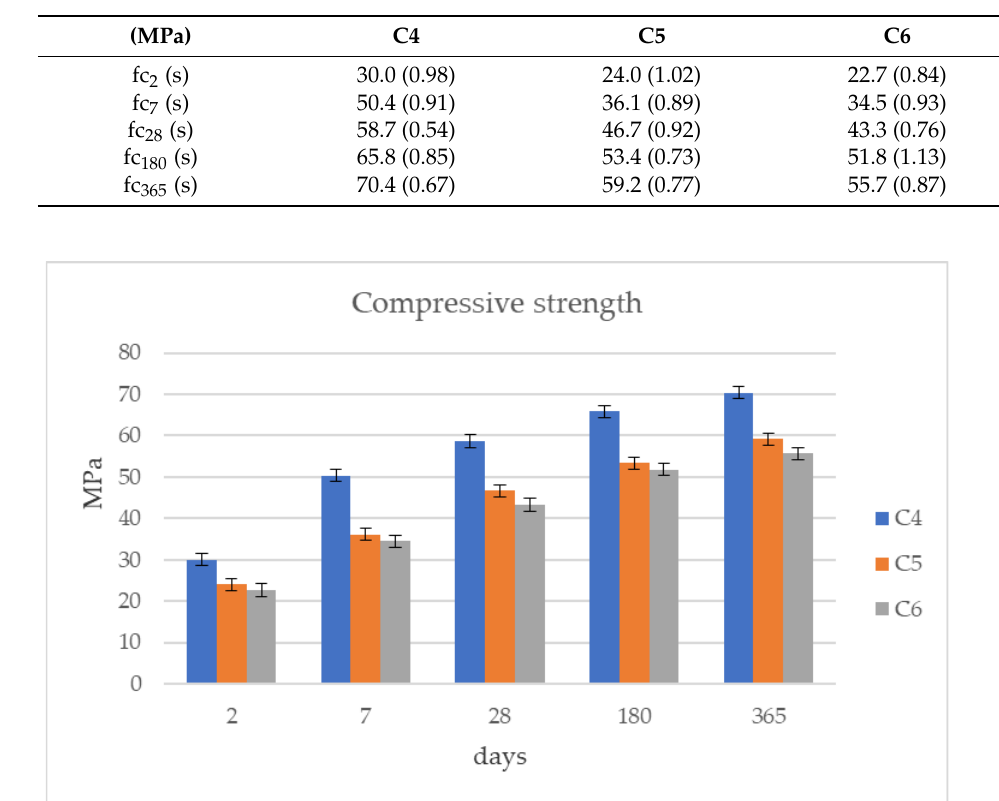
Table 7. Compressive strength (MPa) and standard deviation of C30/37 strength class mixtures.